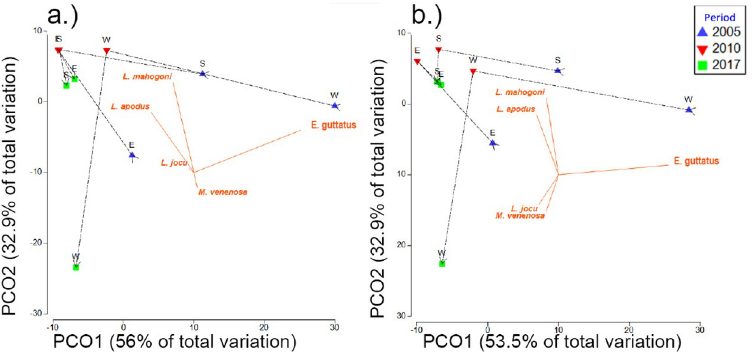
Fig 4. PCO plots of roving density and biomass from the MNTZ. Ordination based upon Bray-Curtis dissimilarities of square-root-transformed density (a) (fish/survey) and biomass (grams/survey) (b) from roving surveys, showing centroids by zone and period overlain with species correlation vectors (Pearson >